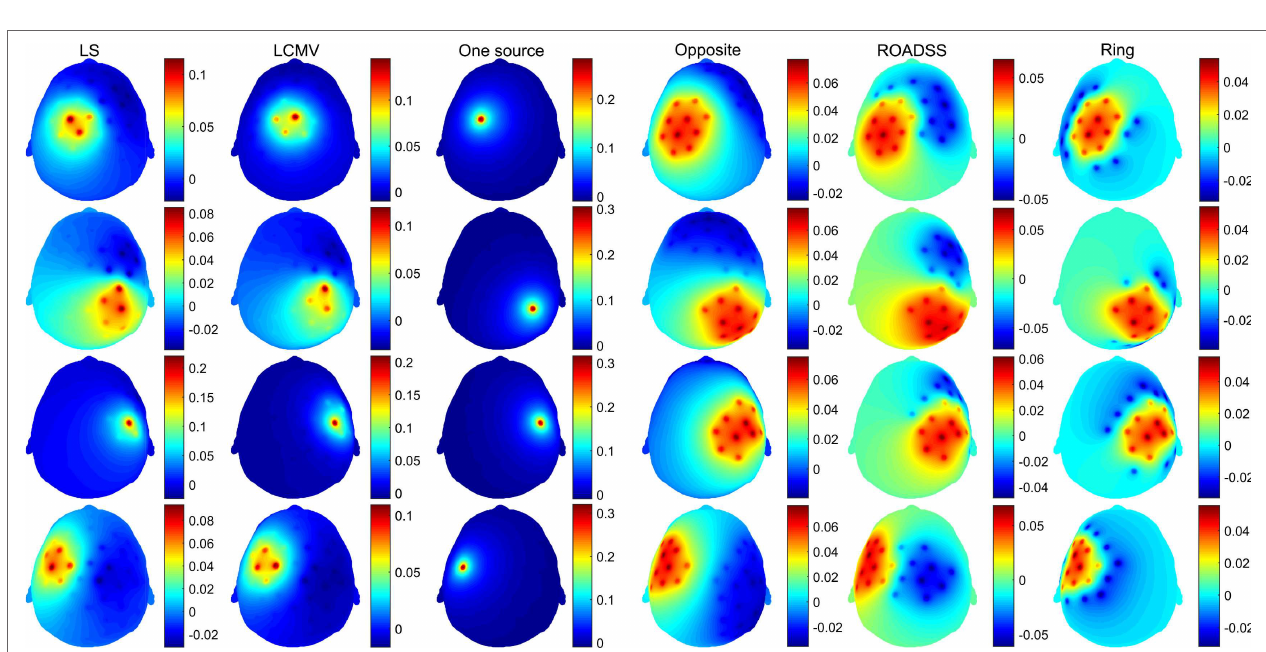
FIGURE 6 | Imprinted electric potential [V] on the scalp for the 128 EGI electrode net . Rows from top to bottom correspond to optimal stimulation of targets T1, T2, T3, and T4; columns correspond to the optimal current injection patterns obtained, from left to right, with the LS, LCMV, “one source,” “opposite,” “ROADSS,” and “ring” methods. The total current injected in each case is 1mA.